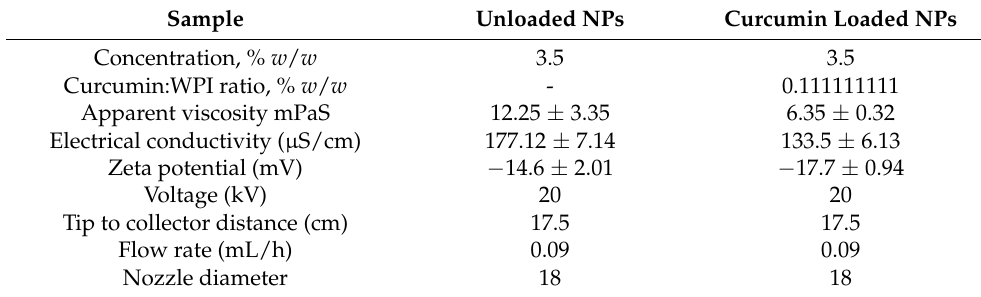
Table 9. Conditions used and properties of nanoparticles (NPs) obtained from walnut protein isolates (WPI) through the electrospraying approach. Reprinted with permission from ref. [131]. Copyright 2021 Springer